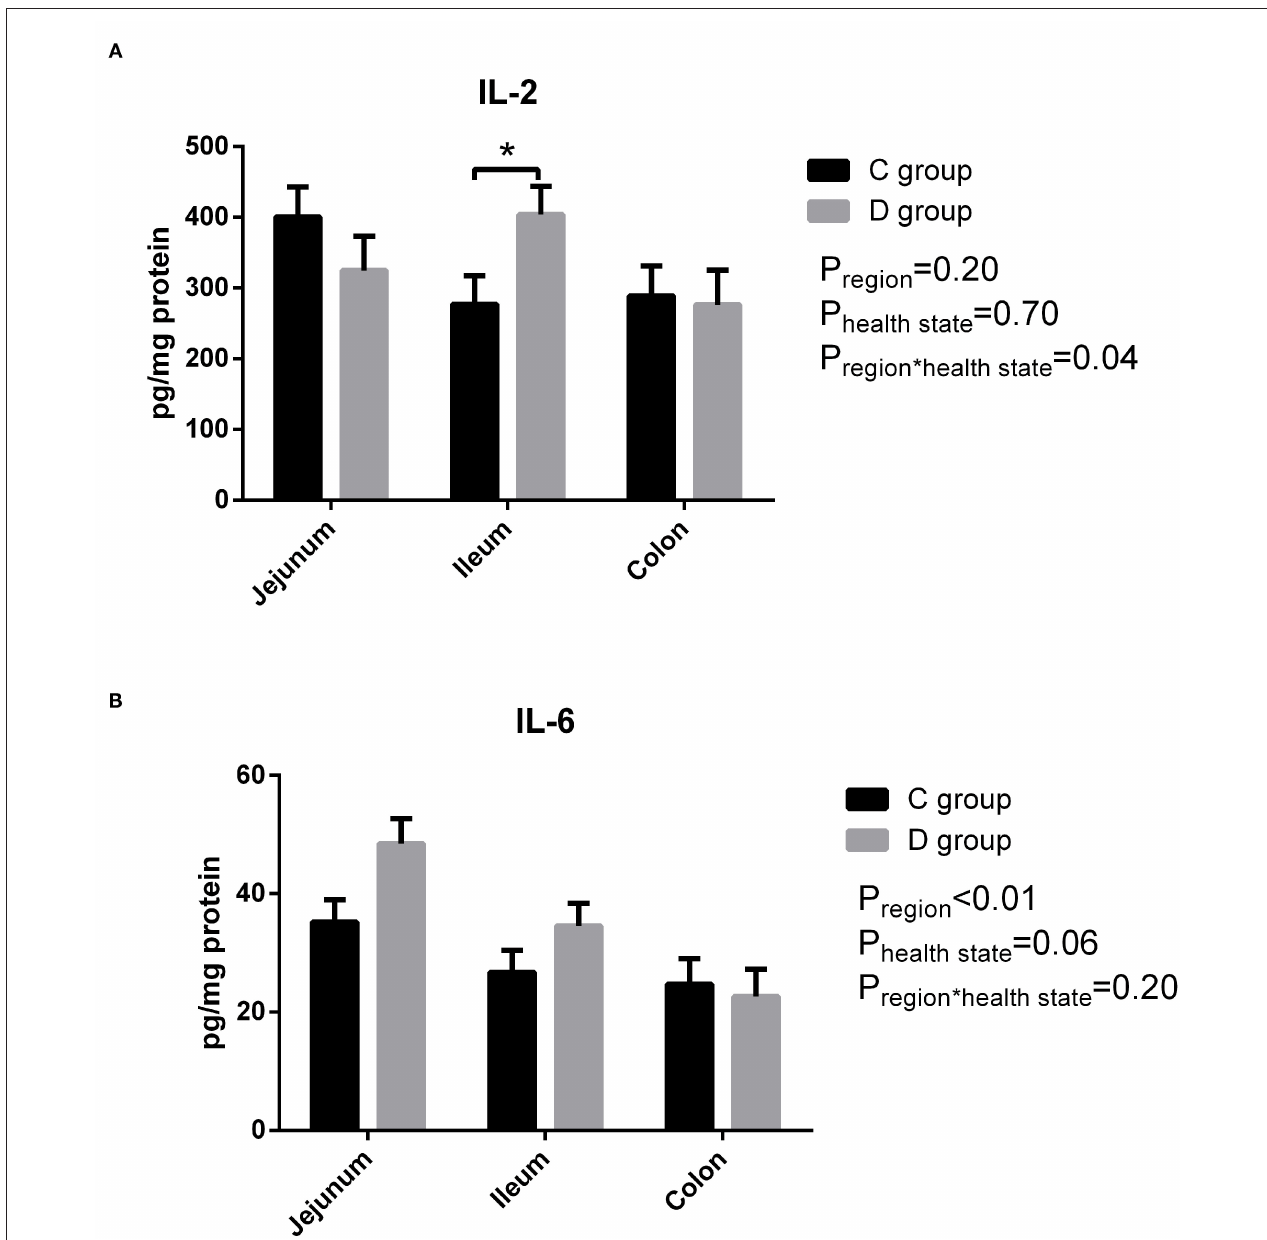
FIGURE 2 | The level of intestinal IL-2 (A) and IL-6 (B) in neonatal diarrhea goats. C group means control group; D group means diarrhea group. Results are expressed as means ± standard error, significance was observed at * P < 0.05 and ** P <